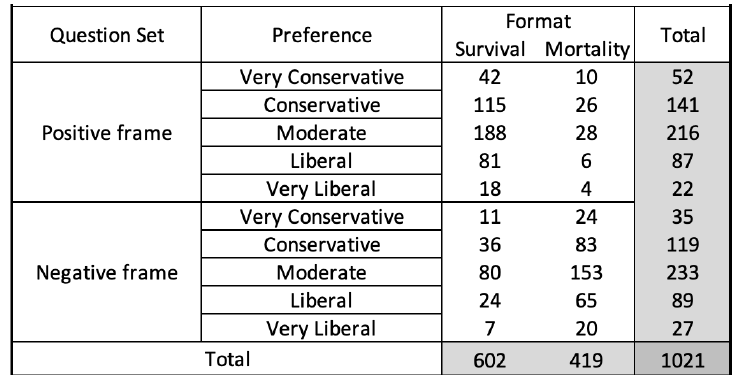
Figure 8. Respondent totals by political preference.